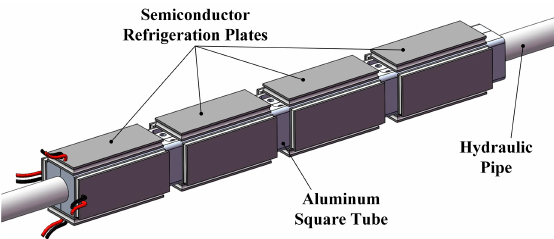
Figure 7. Arrangement of semiconductor refrigerating plates.